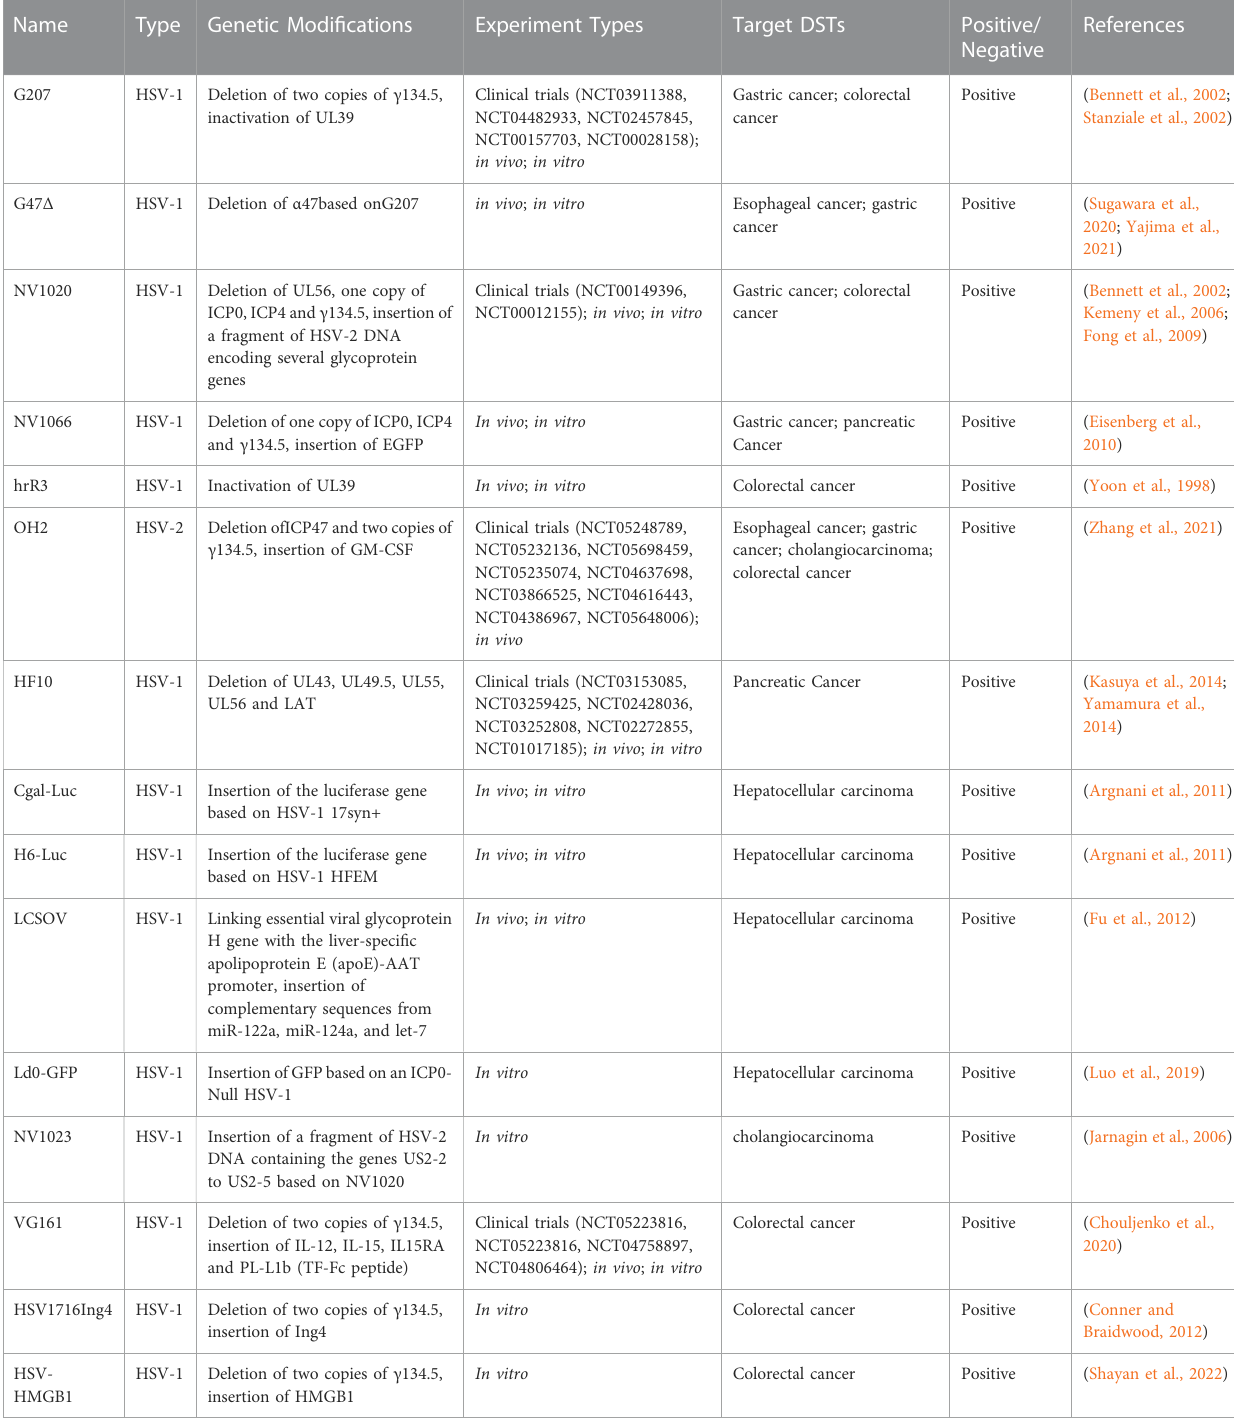
TABLE 1 A summary of genetic modi fi cations and experimental pro fi les of oncolytic